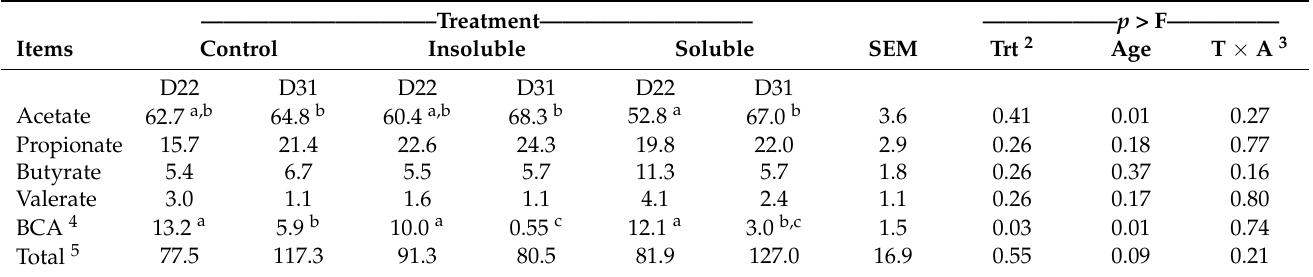
Table 5. Volatile fatty acid (VFA) concentrations (mol%) in the cecum of pigs fed insoluble or soluble gruel creep diets, measured before (D22) or after (D31) weaning, compared with non-creep-fed controls 1 .